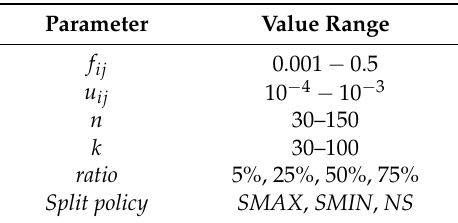
Table 2. Simulation